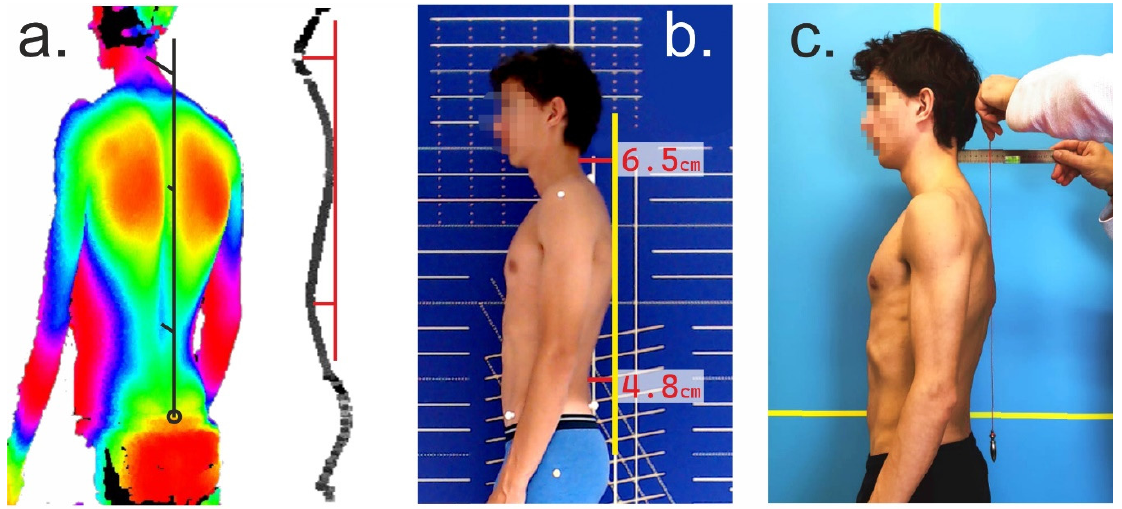
Figure 3. Different methods to determine the parameters flèche cervicale and lombaire . ( a ) 3D stereophotogrammetry, dorsal contour, and lateral profile; ( b ) 2D photogrammetric analysis (analysis of digital photos with graphics software); ( c ) plumb bob and ruler. Note that the ruler has a spirit level to check the horizontal position.